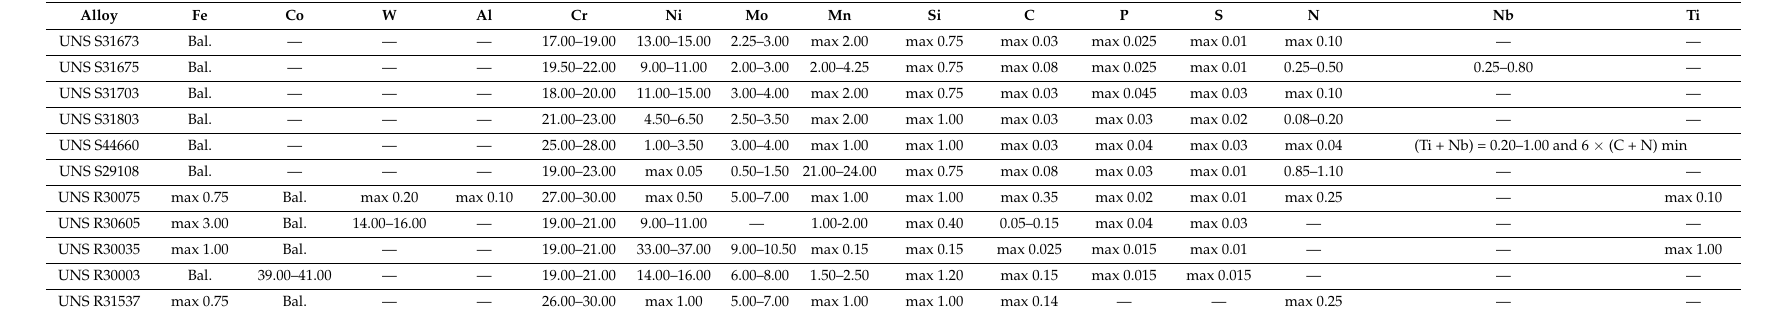
Table 5. Chemical compositions of stainless steels and cobalt-based alloys currently (or potentially) used as biomaterials. Alloy Fe UNSS31673 UNSS31675 UNSS31703 UNSS44660 UNSR30075 max0.75 UNSR30035 max1.00